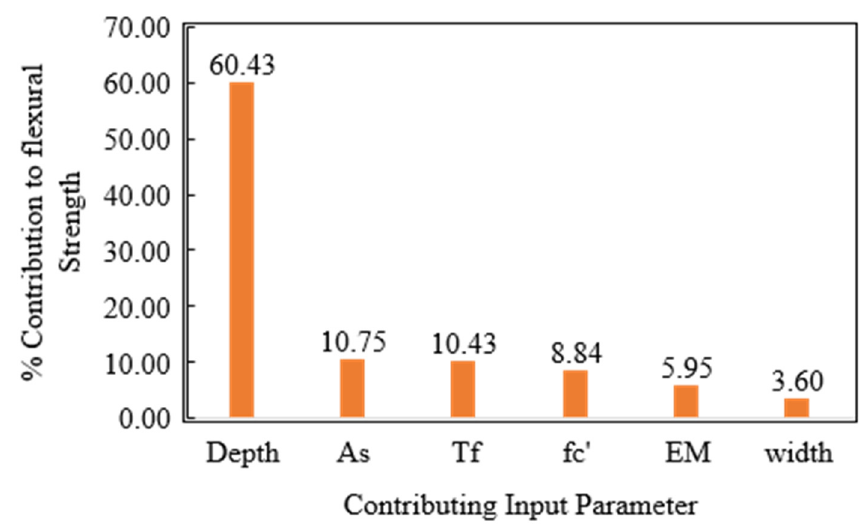
Figure 8. Percentage contribution of input variables using GBT model.